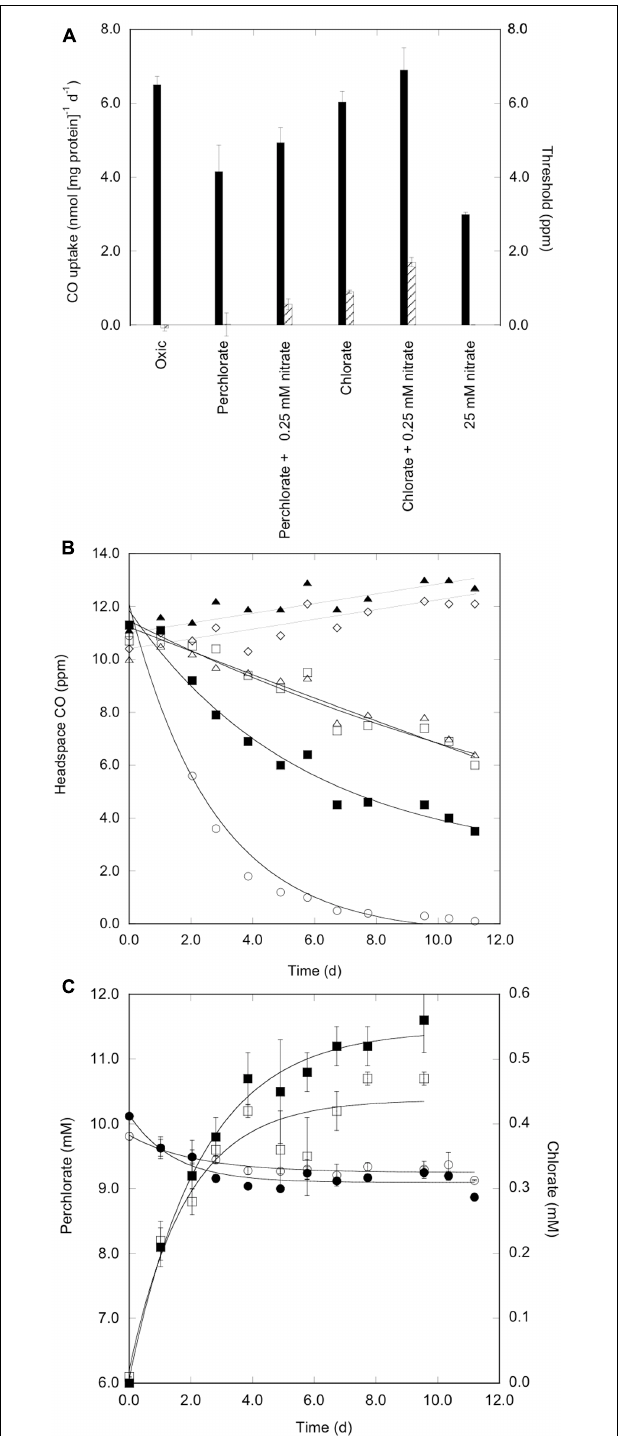
FIGURE 1 | Perchlorate-coupled CO uptake by Haloarcula sp. PCN7. (A) CO uptake rates (nmol CO [mg protein] − 1 d − 1 ; solid bars) and uptake thresholds (ppm; cross-hatched bars) for isolate Haloarcula sp. PCN7 during varied oxic and anoxic incubations in 3.8 M NaCl. (B) Headspace CO versus time for isolate Haloarcula sp. PCN7 during varied oxic and anoxic incubations in